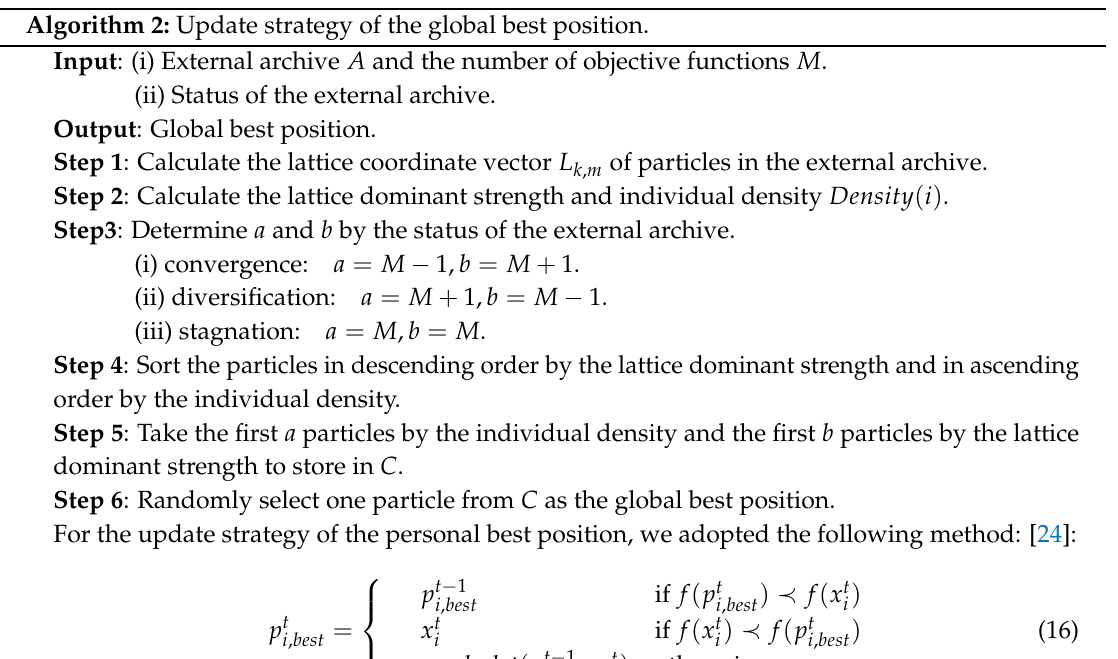
Algorithm 2: Update strategy of the global best